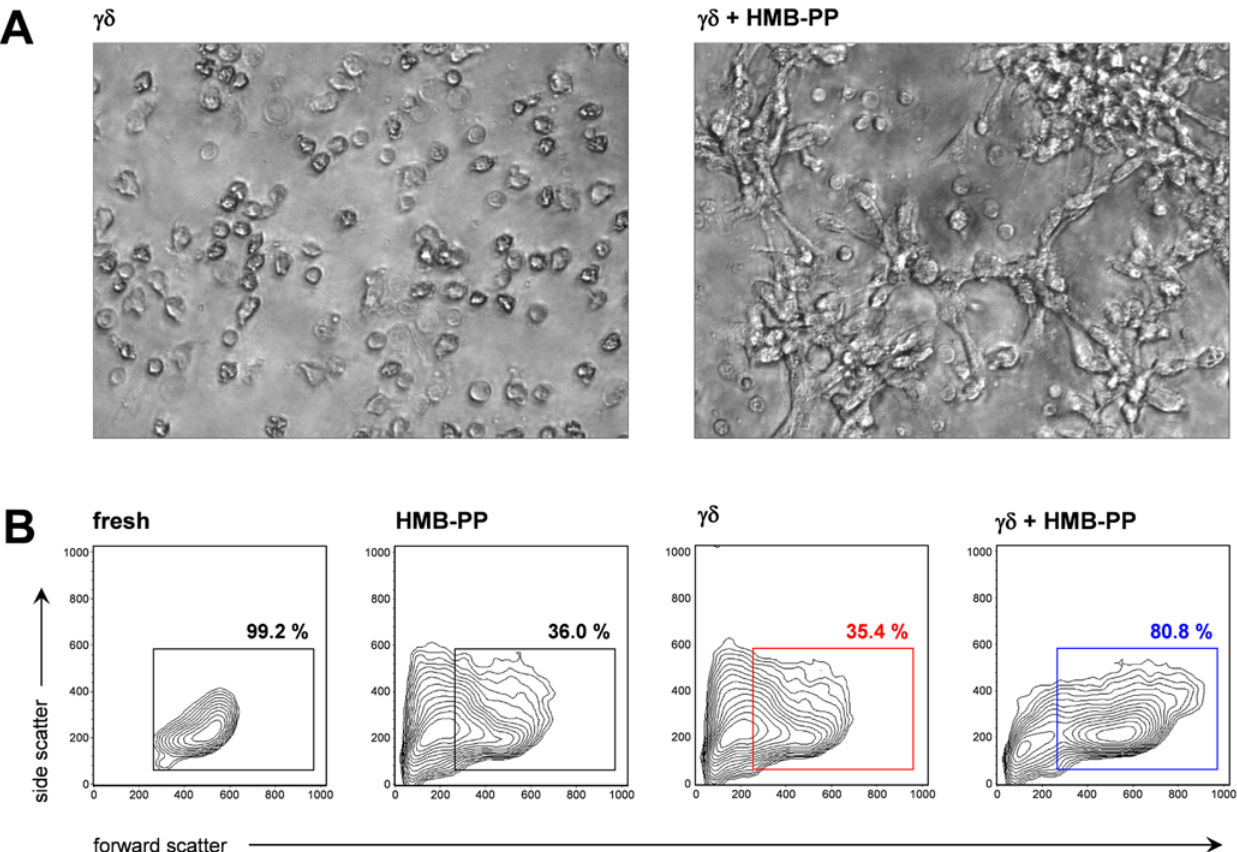
Figure 1. V c 9/V d 2 T cells promote monocyte survival and morphological changes. ( A ) Microscopic analysis of monocytes co-cultured for 18 hours with cd T cells in the absence or presence of HMB-PP, representative of three individual donors. ( B ) Flow cytometric analysis of freshly isolated monocytes, or monocytes cultured in the presence of HMB-PP, cd T cells, or cd T cells + HMB-PP for 42 hours. Data shown are forward and side scatters of all CD3-negative cells, and are representative of three individual